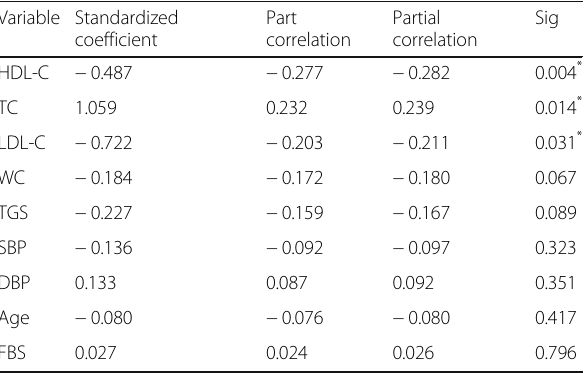
Table 5 Multiple linear regression analysis predicting GCS in all studied patients Variable Standardized coefficient